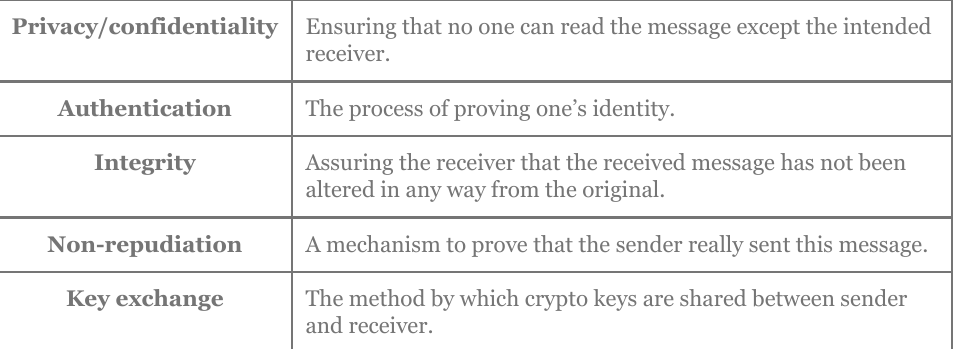
Table 1: Primary functions of cryptography (Kessler, 2019)